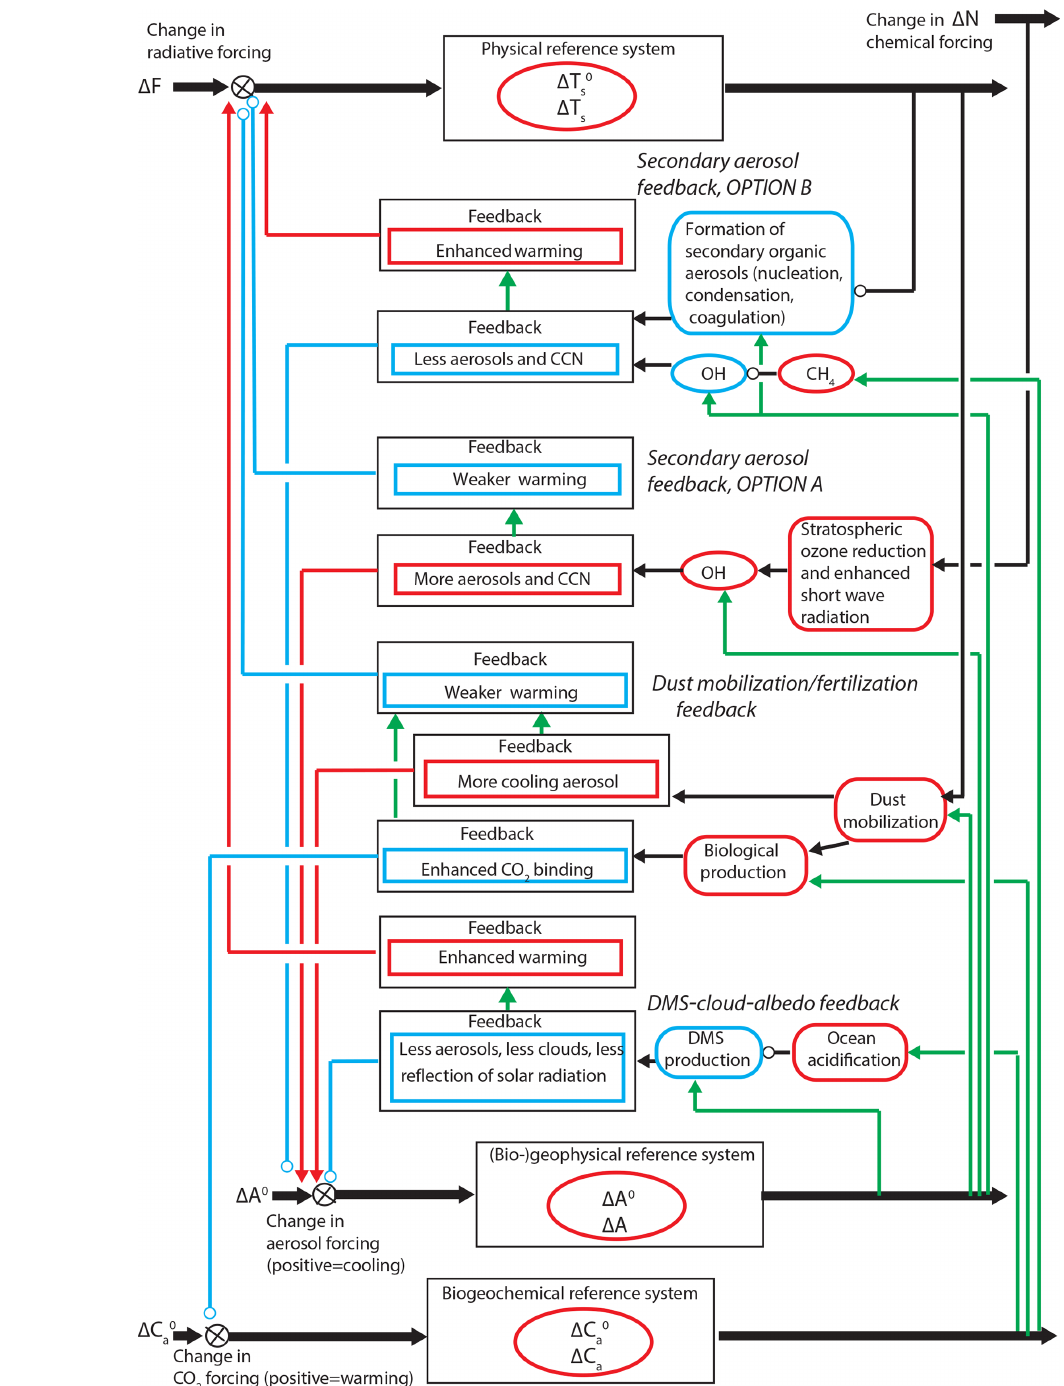
Figure 14. Schematic of important aerosol feedbacks. Arrows indicate positive coupling; open circles indicate negative coupling. Changes in state variables are indicated by ellipses, changes in processes by rounded rectangles. Red indicates increasing values of variables, strength- ening of processes, or positive feedbacks; blue indicates the opposite. Green arrows and lines indicate couplings of biogeochemical processes and aerosol processes to physical processes. The change in surface air temperature (cid:49)T s in the presence of feedback is different from the change (cid:49)T 0 s without feedback. The change in greenhouse gas concentration (cid:49)C a in the presence of a biogeochemical feedback is different from that without this feedback ( (cid:49)C 0 a ). Likewise, the change in aerosols (cid:49)A in the presence of aerosol feedback processes is different from that without this feedback ( (cid:49)A 0